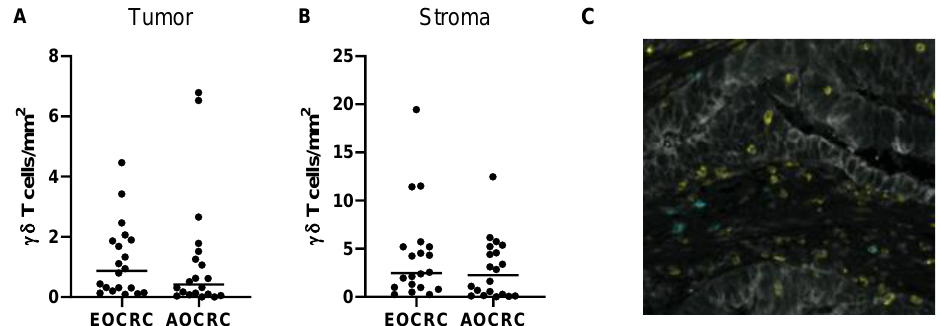
Figure 4. γδ T cells in the tumor microenvironment. The density of γδ T cells in tumors from early onset (EOCRC) and average-onset colorectal cancer (AOCRC) patients was determined by immunofluorescence in tumor tissue ( A ) and tumor stroma ( B ). ( C ) Representative immunofluorescence image from an EOCRC patient with tumor cells (panCK, grey), CD8 + T cells (yellow), and γδ T cells (turquoise). Magnification 260×. Symbols show individual values, and lines indicate the median.